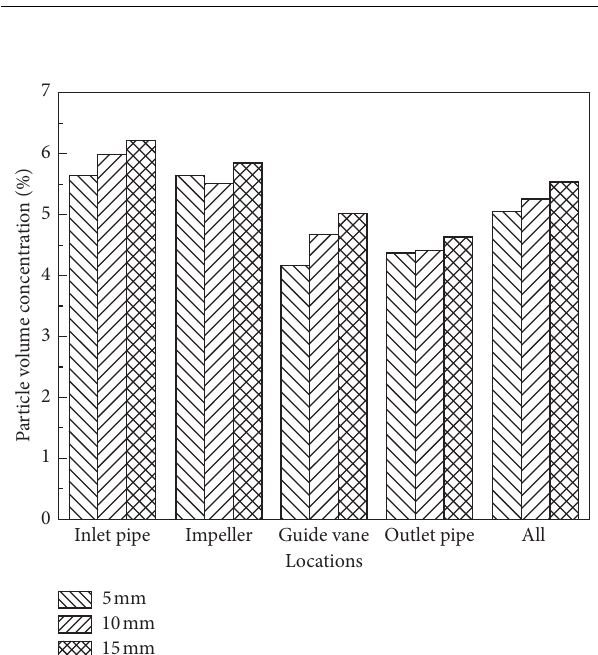
Figure 6: Particle volume concentration at various flow components.